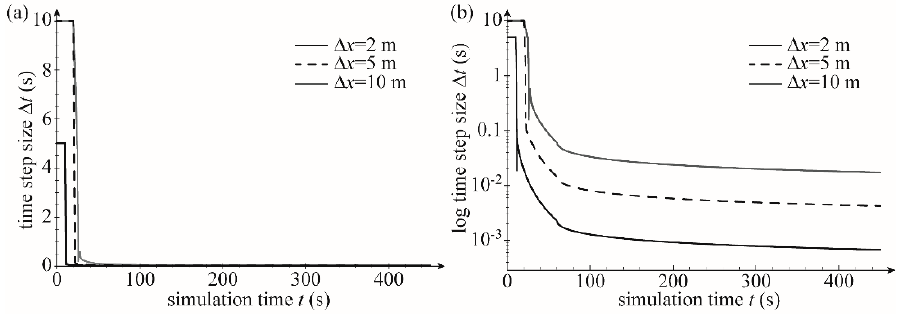
Figure 7. Dependence of the time step length on the simulation time for the ATS method: linear scale ( a ), logarithmic scale ( b ).